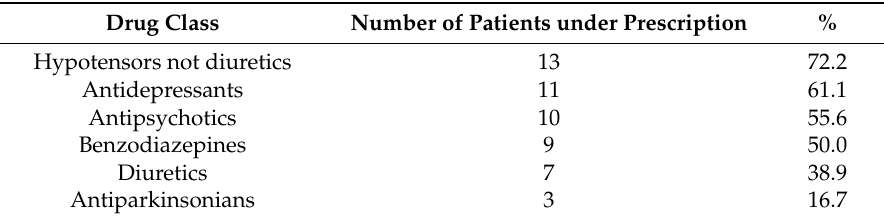
Table 4. Distribution of high-risk medications for falls by the Downton scale. Drug